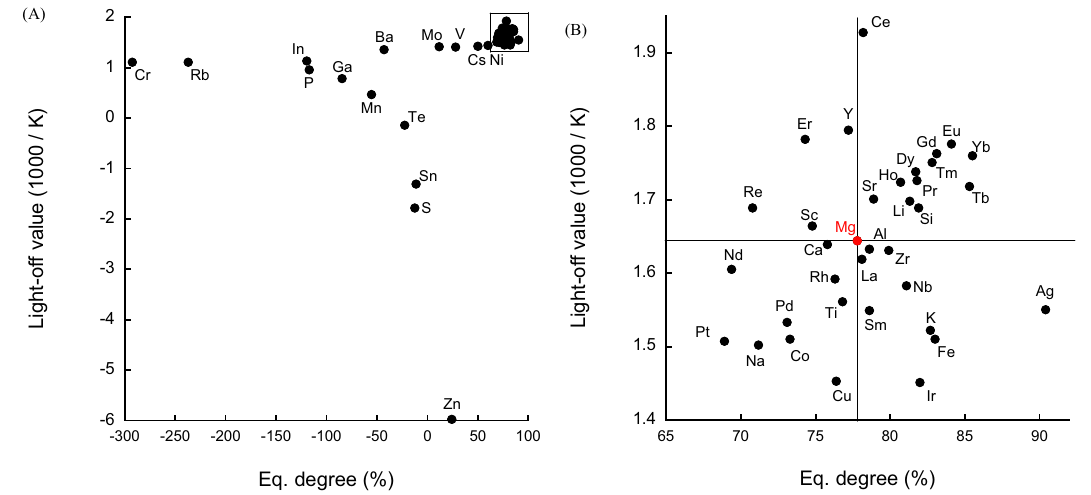
Figure 2. Correlation between Light-off value and equilibrium achievement degree. ( A ) All catalysts. ( B ) Expanded view of the enclosed area in panel ( A ). The elemental symbols correspond to the added